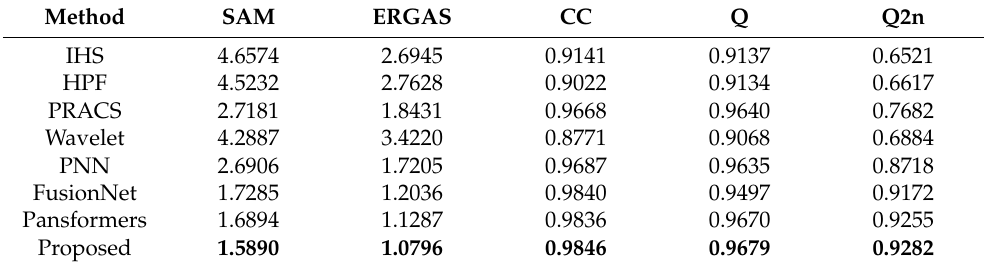
Figure 8. Simulation experiment results using the QuickBird dataset. ( a ) IHS, ( b ) HPF, ( c ) PRACS, ( d ) Wavelet, ( e ) PNN, ( f ) FusionNet, ( g ) Pansformers, ( h ) LNFIN, ( i ) GT. Table 4. Quantitative evaluation of the simulation experiment results using the QuickBird dataset.